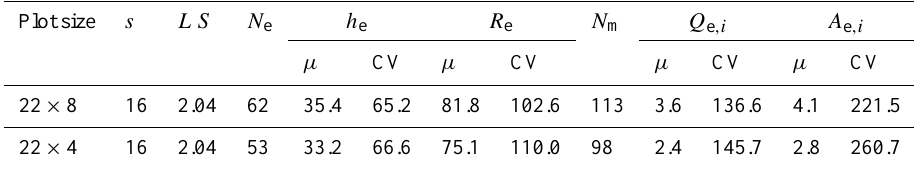
Table 1. Summary statistics of the 22m long plot data available at the Masse site. Plot size